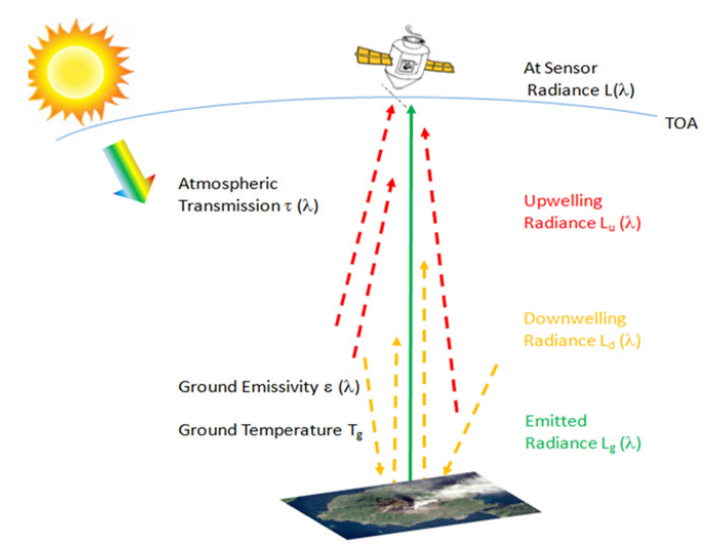
Figure 8. Atmospheric correction to surface temperature estimation.